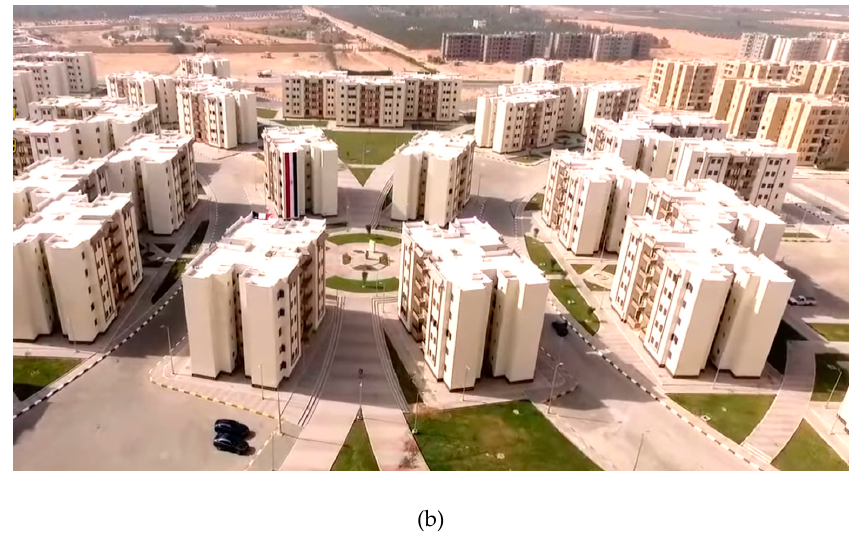
Figure 12. ( a ) Social housing in New Asyiut, the same typology as in 12b [146]. ( b ) Social housing in 10th of Ramadan city [148].